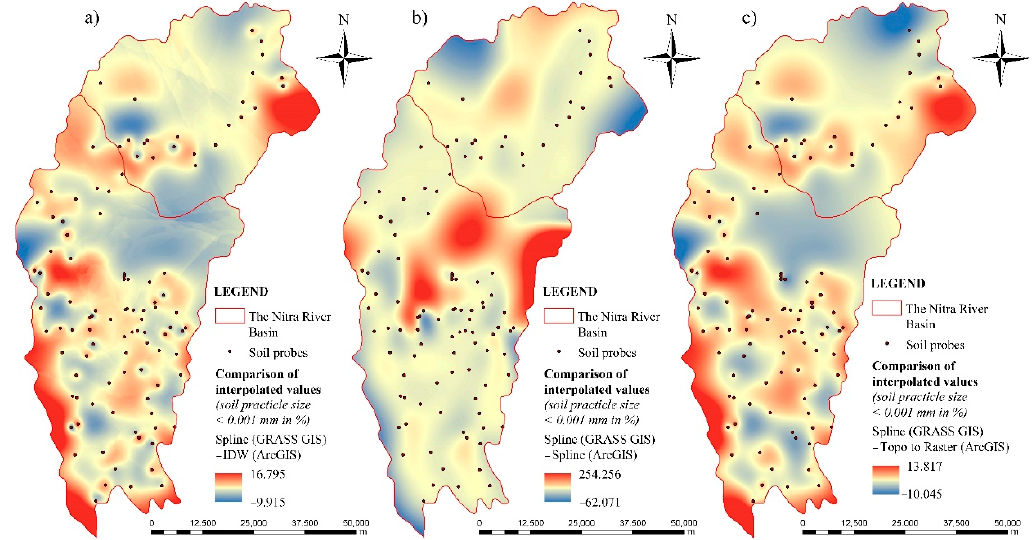
Figure 6. Comparison of GRASS GIS Spline with other interpolation methods for CO x content: ( a ) Spline (GRASS GIS)—